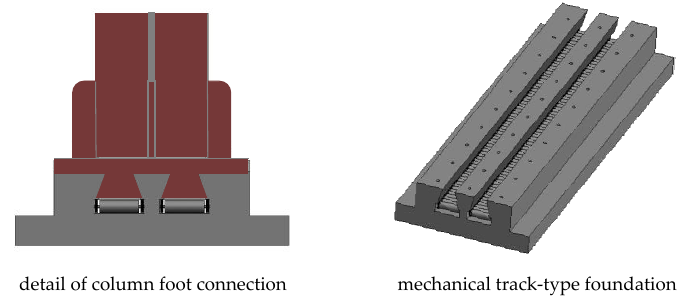
detail of column foot connection mechanical track-type foundation